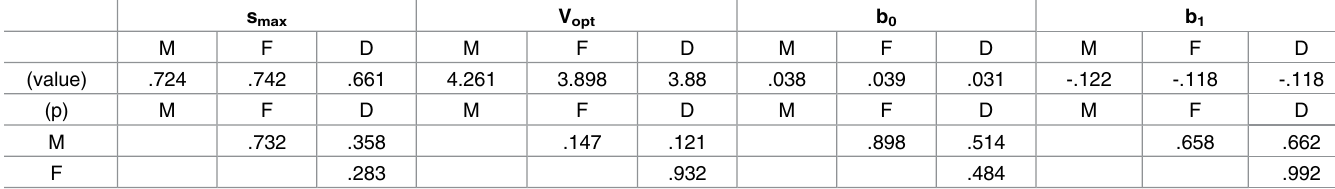
Table 1. The ploidy specific survival functions with parameters estimated by the LOLS (value) and the significance (p) of their differences among (M) males, (F) females and (D) diploids, as estimated from randomization tests. Samplesize n =